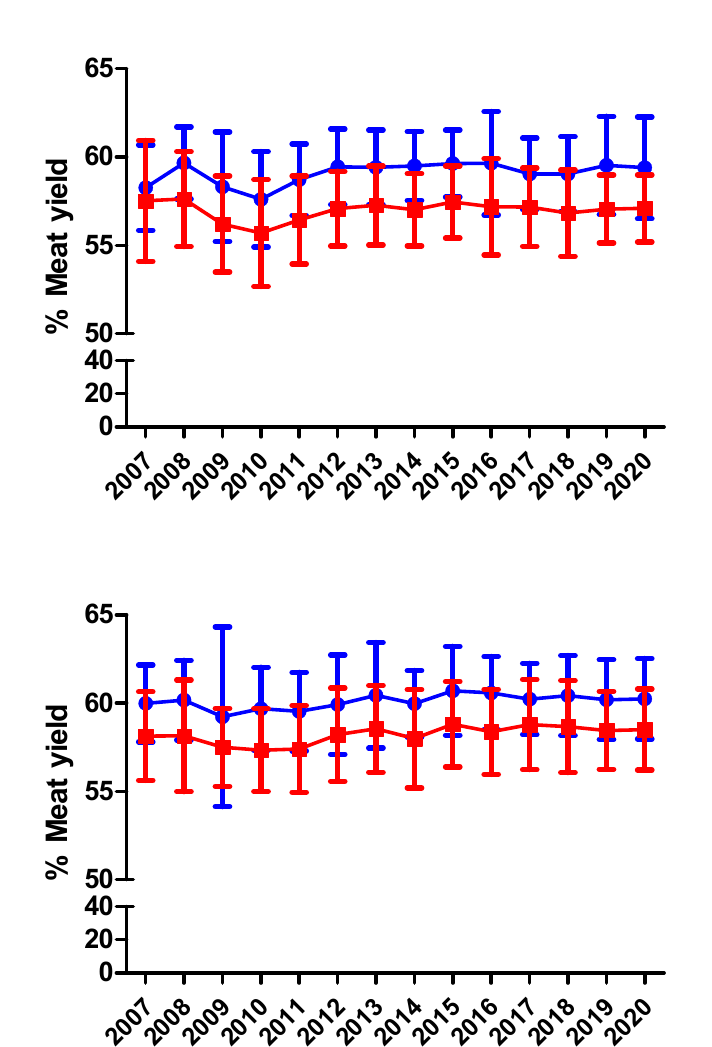
Figure 11. Percentage of meat yield in slaughtered calves from BA ( A ) and BAxL ( B ) split by males (filled circles) and females (filled squares) from 2007 to 2020 in Andorra. Both genders of BAxL crossbreed improved across the years regarding to meat yield ( p < 0.001) whereas this parameter does not show any significant change across the years for both genders of BA ( p > 0.05).